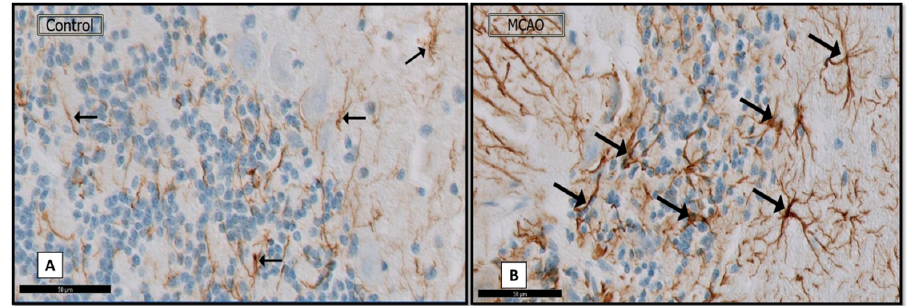
Figure 4. A section showing: ( A ) (control group) mild GFAP positive immunoreactive astrocytes ( ↑ ). ( B ) (MCAO group) strong GFAP positive immunoreactive astrocytes ( ↑ ). (GFAP × 40; Scale bar = 50 µ m).